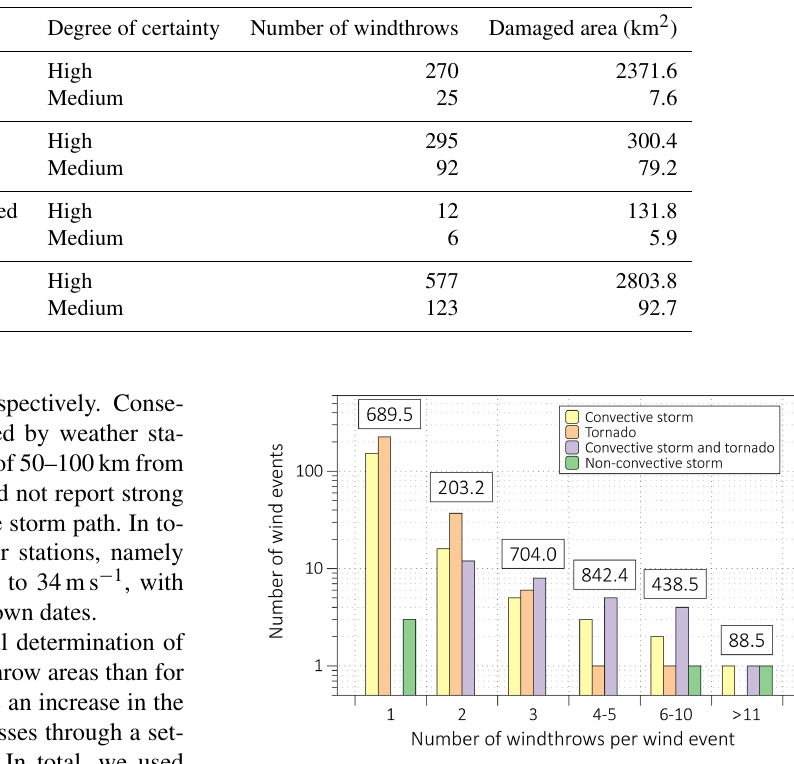
Figure 9. Number of windthrows per one storm event. The total damaged area (in km 2 ) corresponding to all types of windthrows is shown in the box for each